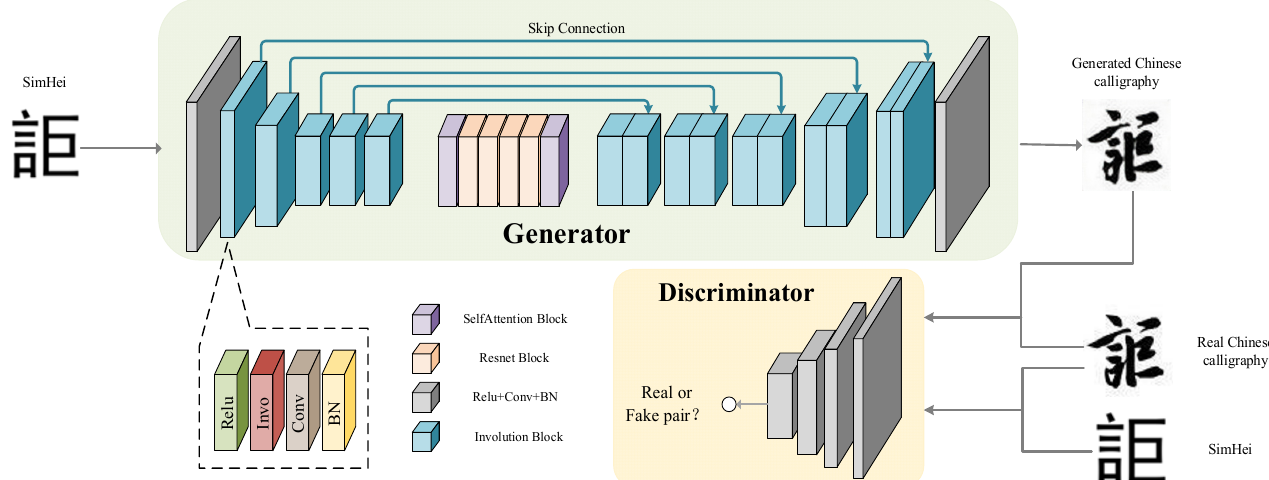
Figure 2. The generator is used to convert the printed fonts (SimHei) to the target calligraphic font. The discriminator is used to determine the authenticity of the image. The blue block is the involution block, the gray block is the convolution block, the purple block is the self-attentive block and the orange block is the residual block.